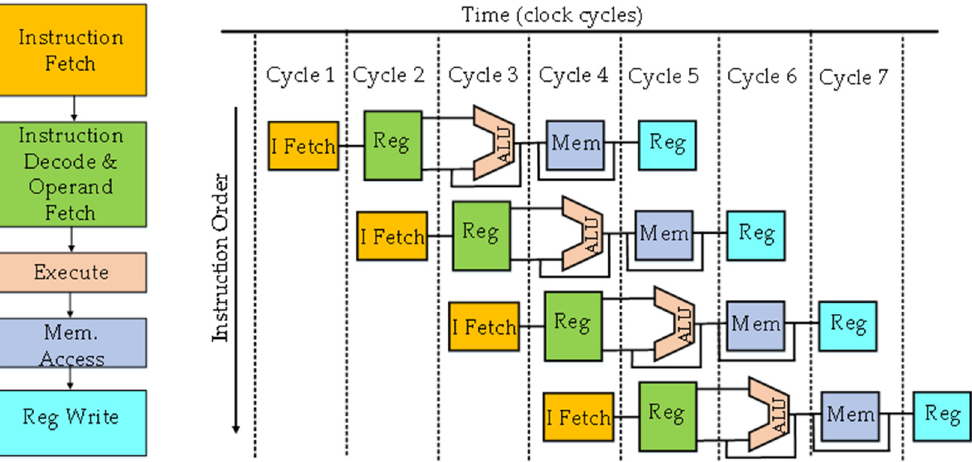
Figure 4. Five stages of pipelining in microprocessors. Table 1. Basic features of popular superscalar microprocessors